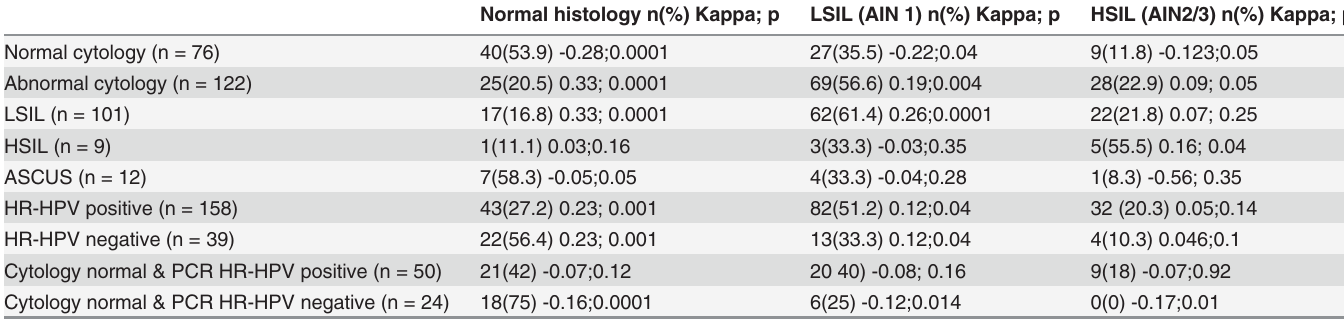
Table 4. Correlations between cytology and PCR of HR-HPV of anal mucosa and